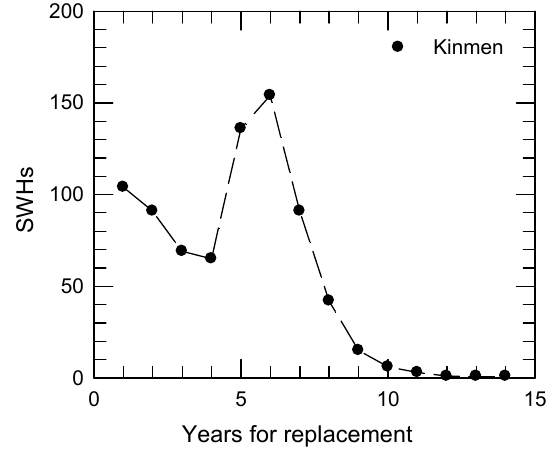
Figure 10. Historical data for certified installers in Taiwan and Kinmen County.